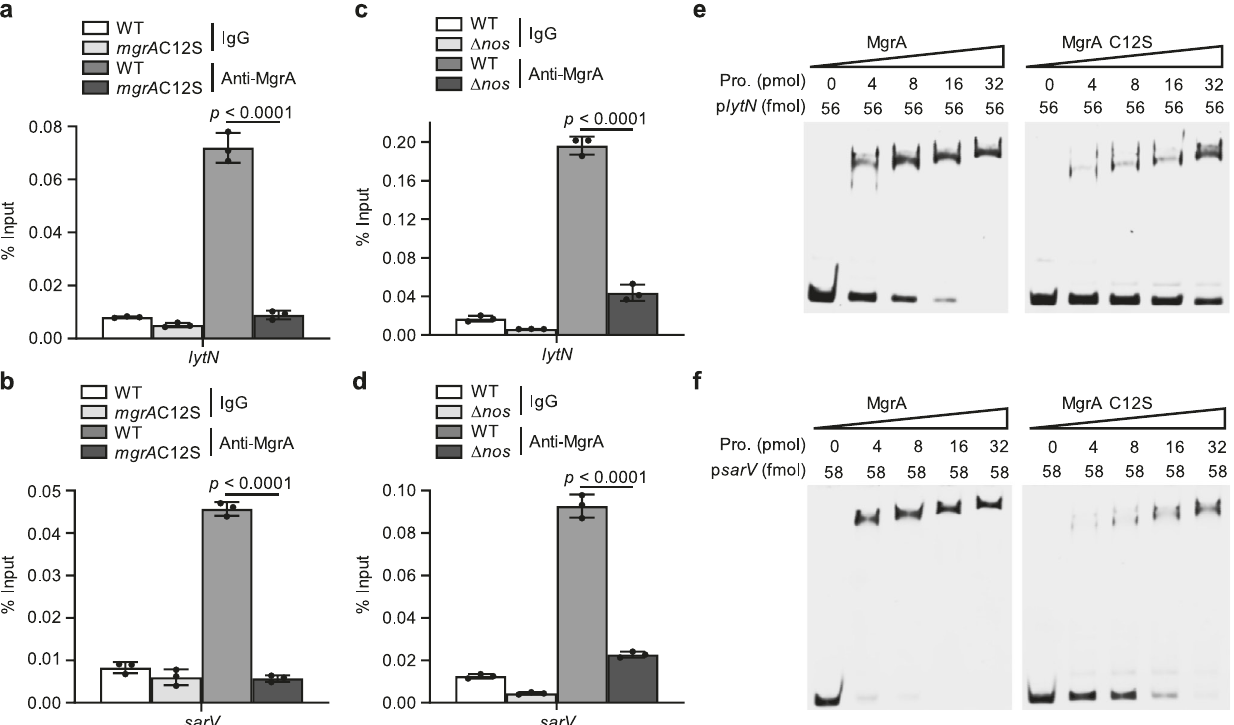
Fig.5|RemovalofMgrAS-nitrosylationimpairsitsDNAbindingactivity. ChIP- qPCRwasusedtoevaluatetheoccupancyofendogenousWTMgrAorMgrAC12Sat the promoters of lytN and sarV ( a , b ),and the occupancyof endogenous WT MgrA intheWTor Δ nos strains( c , d ).Dataaremeansof n =3biologicalreplicateswithSD. Two-sidedunpairedStudent ’ s t -test,**** p ≤ 0.0001.DNAbindingef fi cacyofWTand C12SmutantMgrAat lytN ( e )or sarV ( f )promoterswascomparedbyusinggel-shift